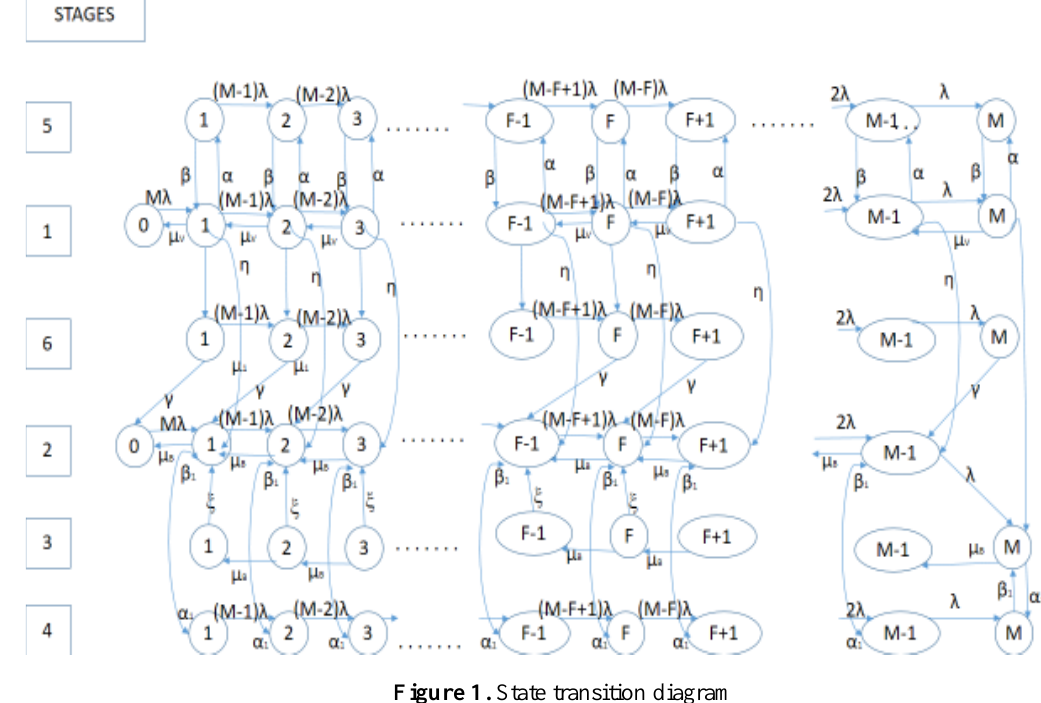
Figure 1. State transition